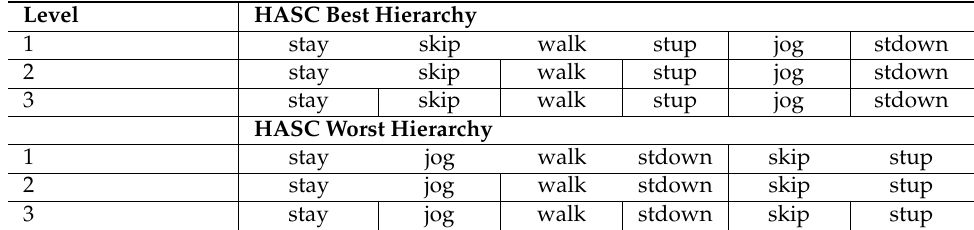
Table 4. Class hierarchy with maximum and minimum accuracy in all trials.